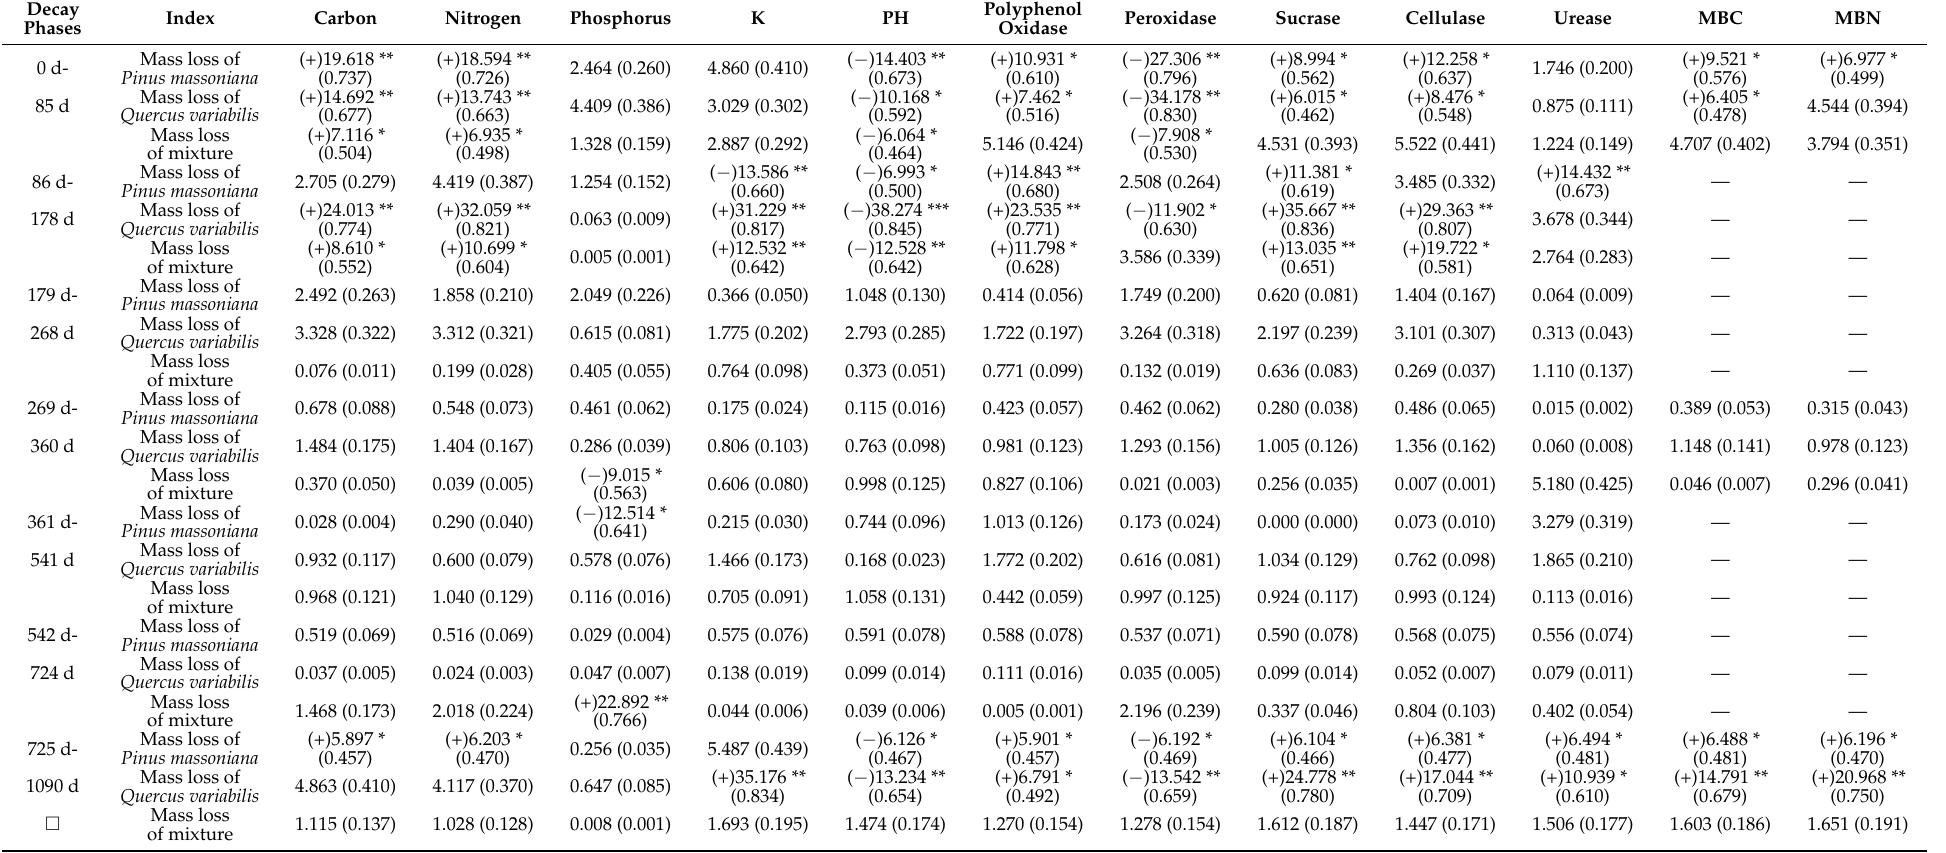
Table 3. Regression analyses of changing soil traits and the litter mass loss rate (loss of initial per